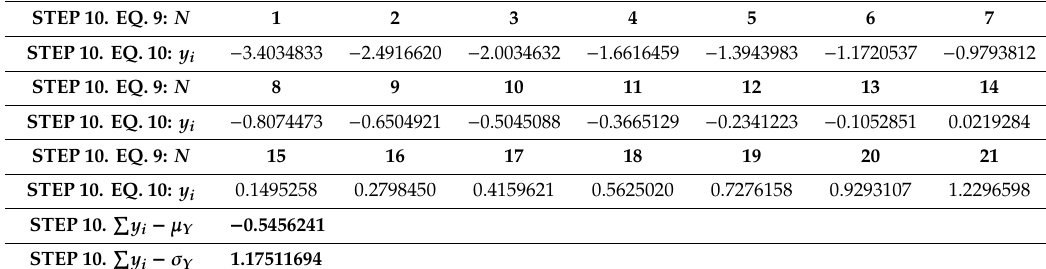
Table 1. Mean µ Y and standard deviation σ Y .